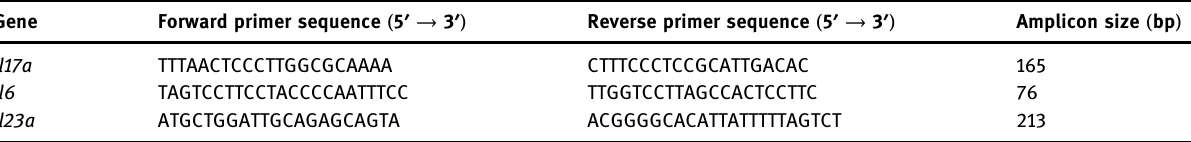
Table 1: Primer for real - time qPCR